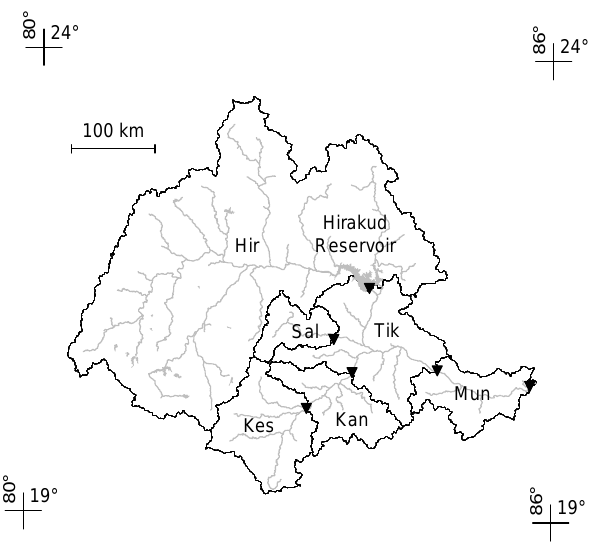
Figure 1. Mahanadi River basin with the analysed gauges (trian- gles) and their catchments. Gauge names are abbreviated: